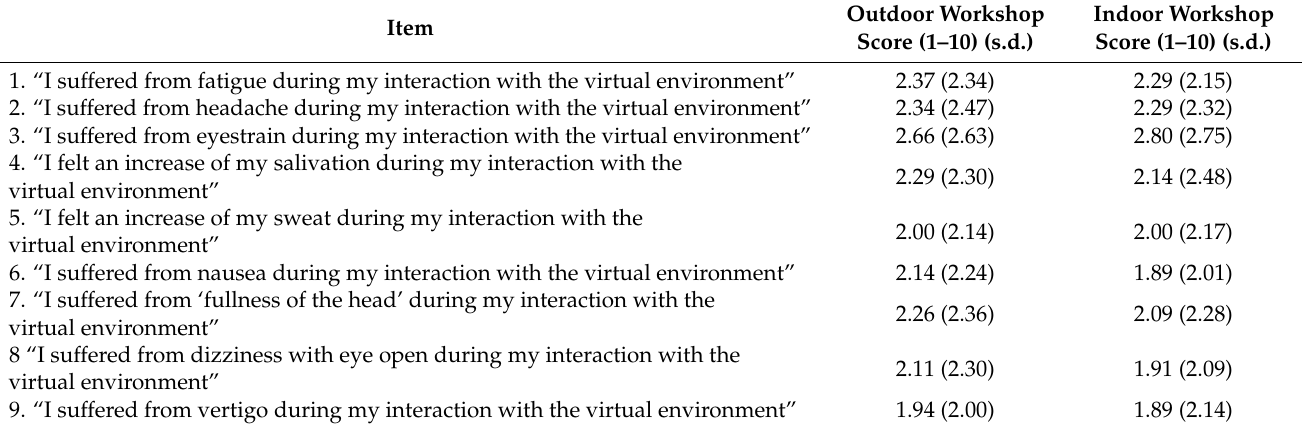
Table 10. Questionnaire on User experience in Immersive Virtual Environments: experience conse- quence subscale.